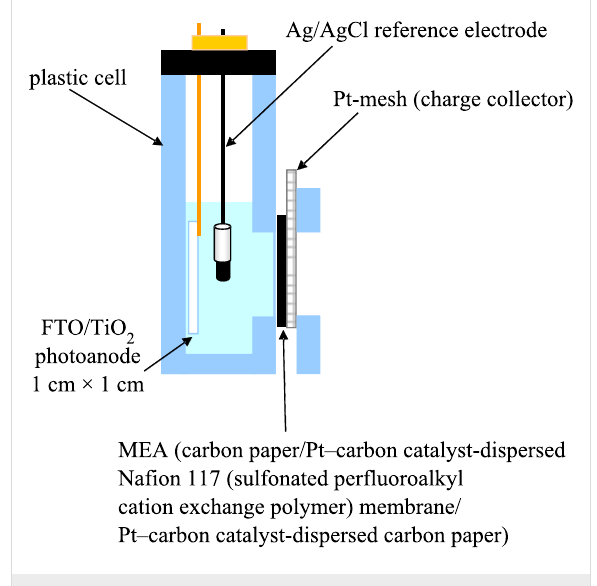
Figure 1: Side view of a photoelectrochemical cell (1 cm × 1 cm × 3 cm) used for CV measurements with membrane electrode assembly (MEA) attached to a Pt-mesh cathode.